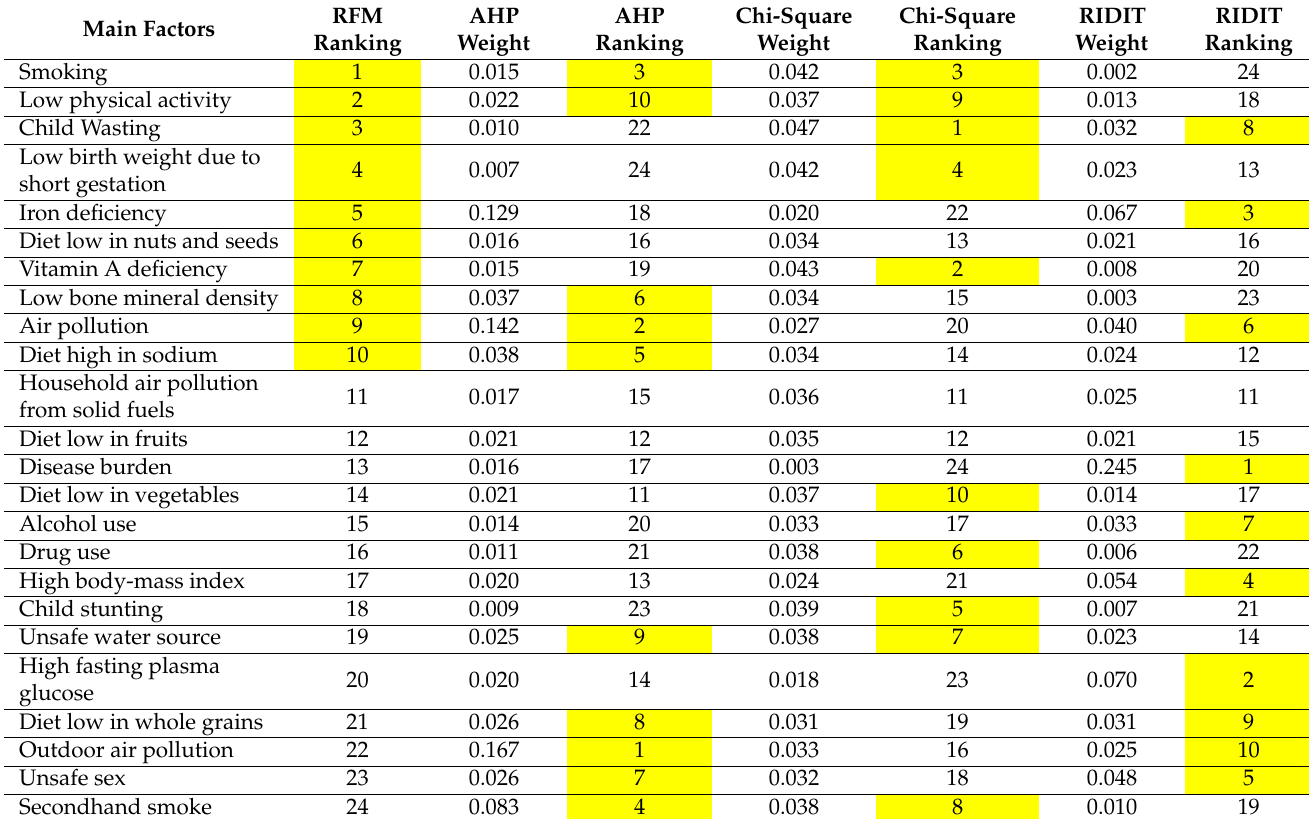
Table 9. Comparison of the analysis results from different